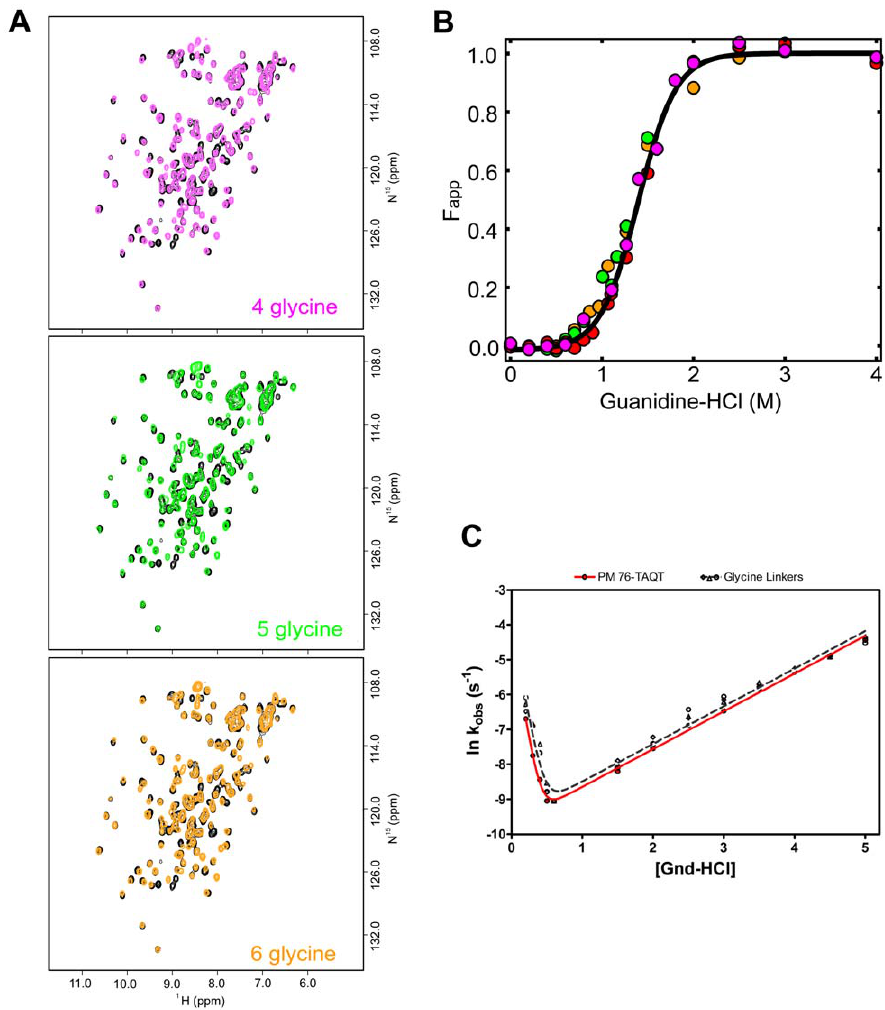
Figure 5. Plots of the (A) 1 H- 15 N-HSQC spectra, (B) equilibrium titration and (C) chevron plot showing similar tertiary structure and no variation in equilibrium stability, cooperativity, or folding kinetics due to linker size or composition. (A) These representative spectra were acquired to determine the effects of linker length and composition on the global fold of the protein. Each linker variant spectrum is overlaid with the spectrum of WT IL-1 b (black). (Top) The spectrum of the linker variant of PM76 with 4-glycine (4G) replacing TAQT overlaid in magenta. (Middle) The spectrum of the 5-glycine linker variant (5G) overlaid in green. (Bottom) The spectrum of the 6-glycine linker variant (6G) overlaid in orange. The overall pattern remains unaffected by the linker variations. (B) An overlay of linker variants equilibrium denaturation curves PM76 with the TAQT linker (red), 4G (magenta), 5G (green) and 6G (orange) plotted as F app versus denaturation concentration. The continuous line representing the best-fit curve is fit to a two-state model is shown in black. (C) A chevron plot of the relaxation rates obtained by both stopped-flow and manual mixing refolding and unfolding experiments indicating the similarities in linker variants. The observed rates of PM76 with the biologically active TAQT linker (black data points) and 4G, 5G, and 6G (open data points) linker variants are plotted